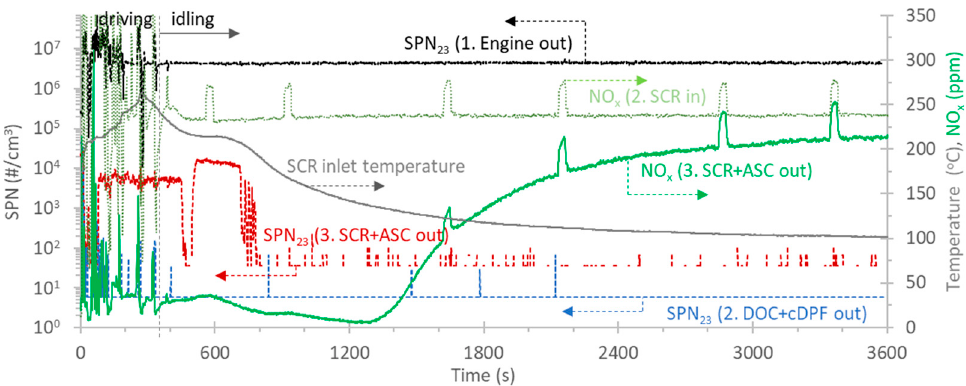
Figure 3. Idling test. The different colors represent different sampling locations. ASC = ammonia slip catalyst; DOC = Diesel oxidation catalyst; cDPF = catalyzed Diesel particulate filter; SCR = selective catalytic reduction; SPN = solid particle number.